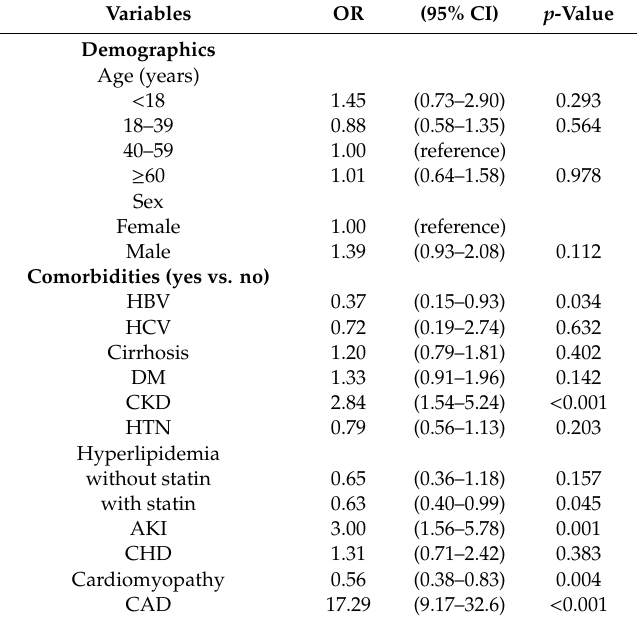
Table 5. Multivariate logistic regression analysis of risk factors associated with early dialysis (non-dialysis vs. early dialysis).